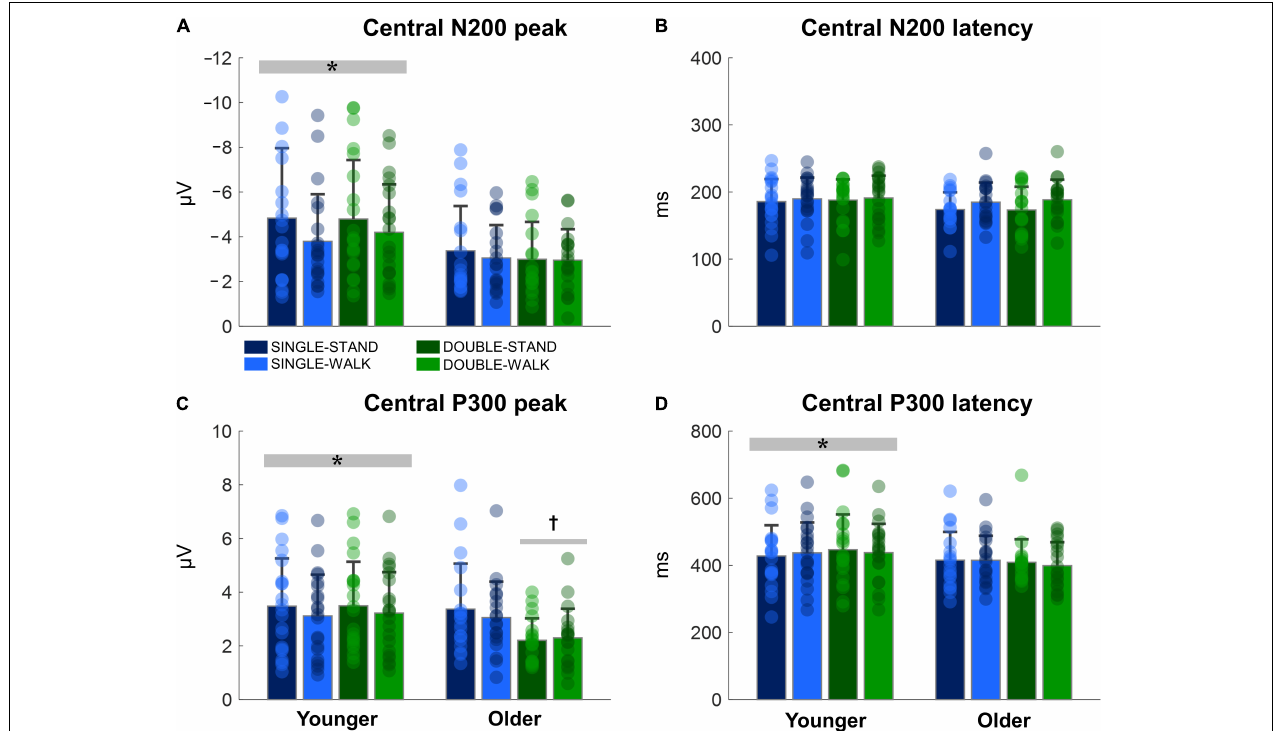
FIGURE 5 | Mean (SD) and individual values of N200 peak (A) , N200 latency (B) , P300 peak (C) , and P300 latency (D) in four conditions for the averaged central channels (C3, Cz, and C4): single stimulus while standing (SINGLE-STAND), single stimulus while walking (SINGLE-WALK), double stimuli while standing (DOUBLE-STAND), double stimuli while walking (DOUBLE-WALK) for younger and older adults. *Denotes significant difference in relation to older adults ( p < 0.05). † Denotes significant difference in relation to single stimuli conditions for the same group ( p <